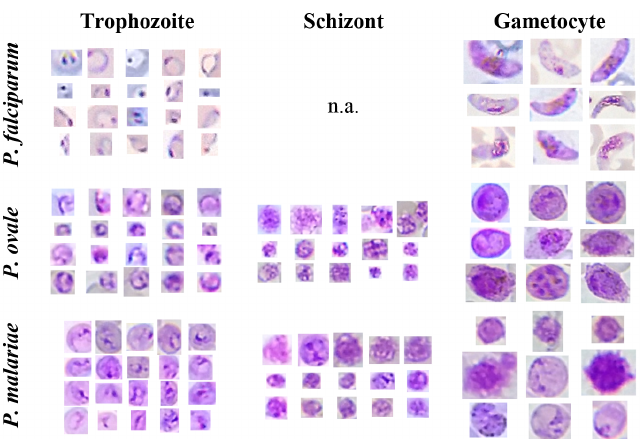
Figure 4. Illustrative examples of different MPs species and life cycle stages from the Mobile Thin Smear Malaria Parasites (mThinMPs) database.